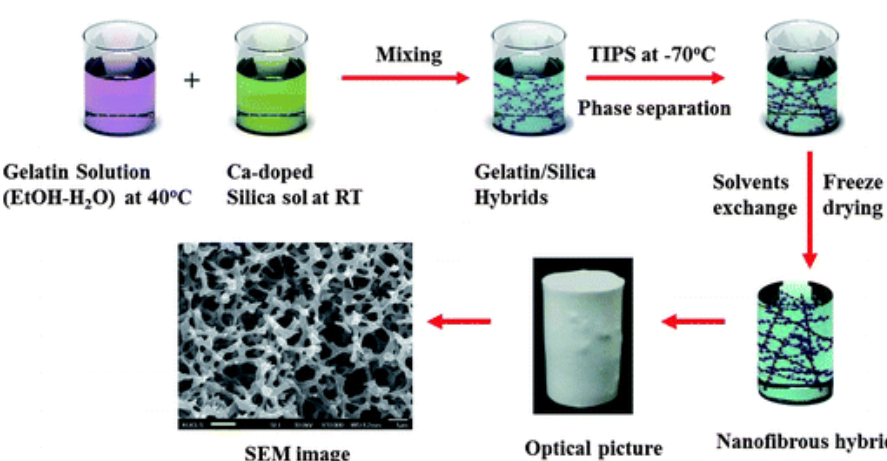
Figure 3. Temperature induced phase separation process (TIPS). Reprinted with permission from [24]. Copyright 2012 Royal Society of Chemistry.